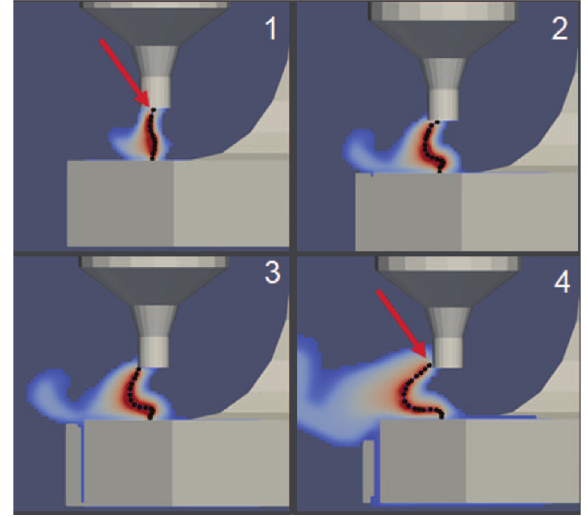
Fig. 2. Attachment and movement of upper electrode end particle, denoted by the red arrow.